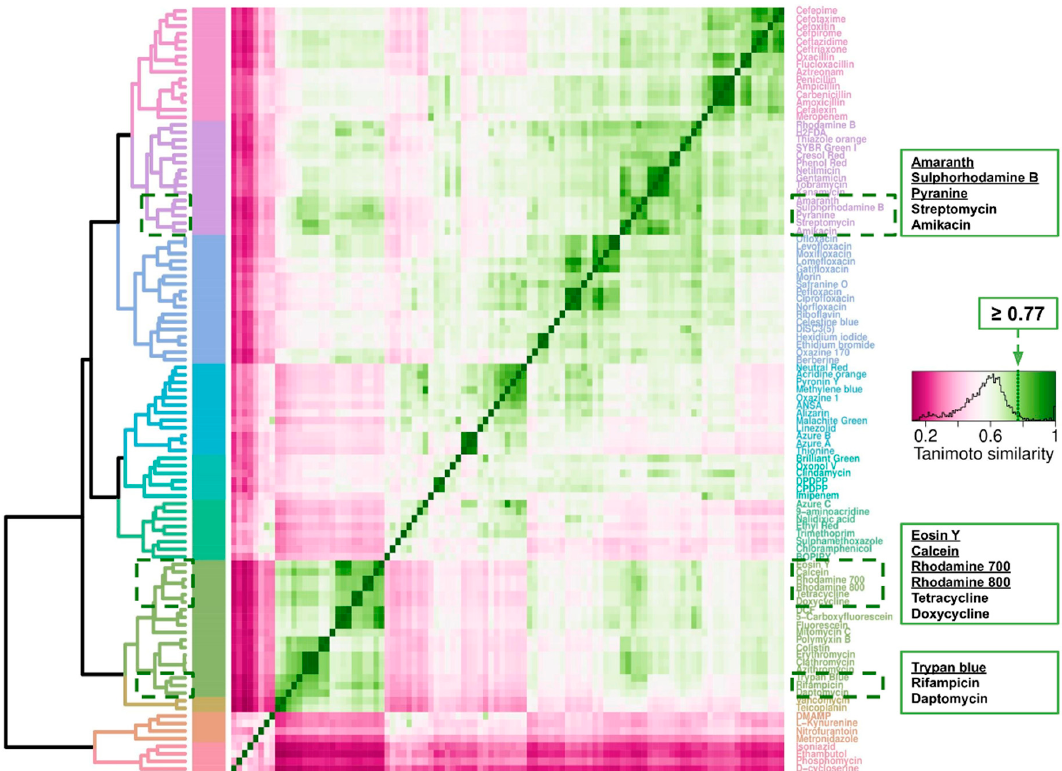
Figure 12. Chemical structure similarity of the antibiotics compiled in this study and some fluorescent molecules known to accumulate in bacteria. Heatmap and dendrogram representing the Tanimoto similarities (derived as described in the methods) of 47 fluorescence compounds known to accumulate in E. coli [129] and the 54 antibiotics listed in this paper. Scale from zero (least similarity) to 1 (highest similarity). Dotted boxes indicate clusters with a Tanimoto similarity greater than or equal to 0.77 (a cut-off for similar bioactivities is accepted at about 0.8). The three clusters where antibiotics and fluorophores have this level of structural similarity are re-written in framed boxes with the non-antibiotic fluorophores underlined in each case.